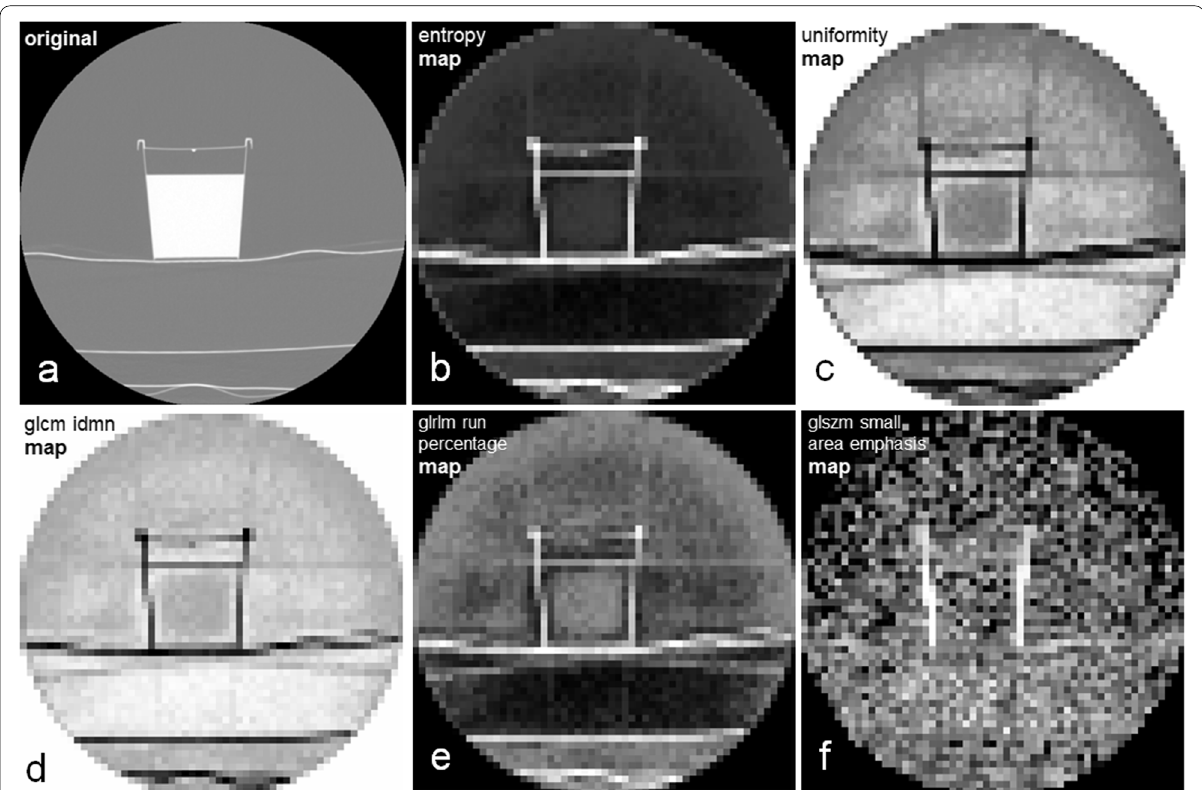
Fig. 5 Exemplary parametric maps. The original computed tomography scan of the phantom is shown in the left upper corner ( a ). The exemplary maps represent the quantity of the respective feature. The higher the feature quantity for a voxel, the brighter the voxel appears on the map. The map of GLSZM small area emphasis ( f ) illustrates that the feature quantity of the background is almost similar to the body of the phantom. In the maps of entropy ( b ), uniformity ( c ), GLCM IDMN ( d ), and GLRLM run percentage ( e ), lines appear in the extension of edges and interfaces of the phantom. A high signal in the background can also be